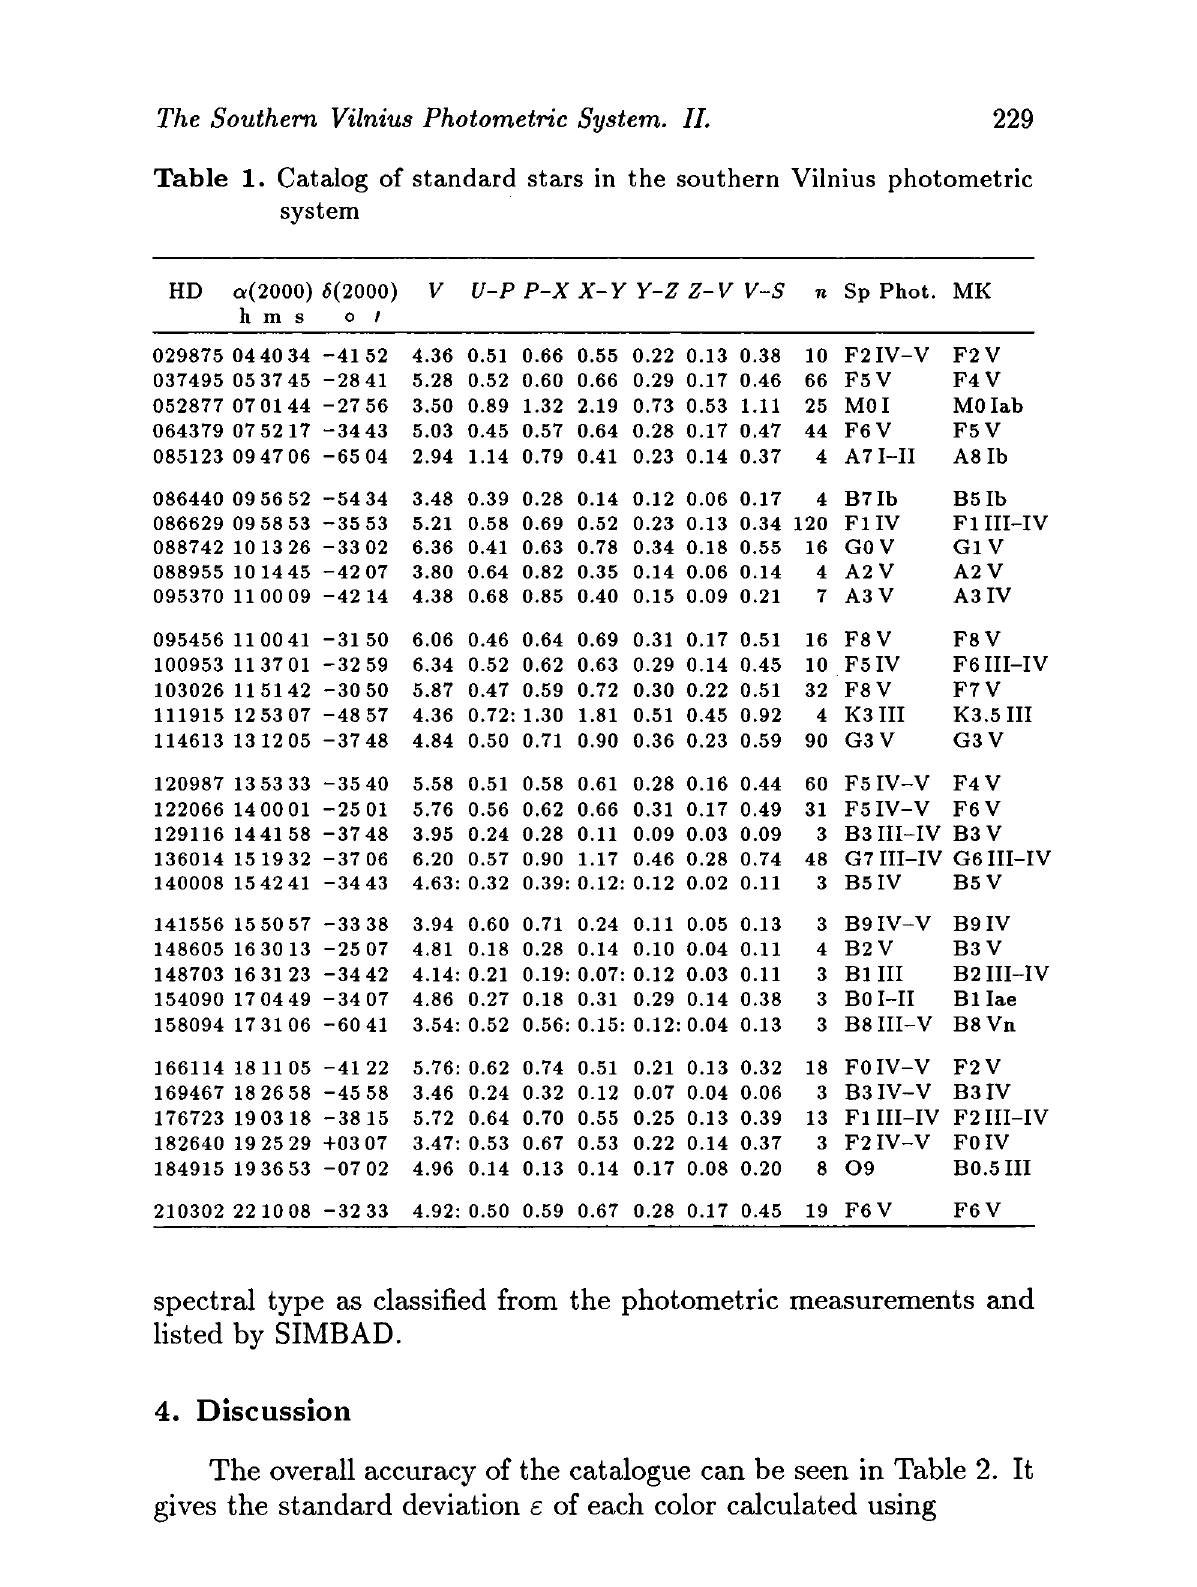
Table 1. Catalog of standard stars in the southern Vilnius photometric